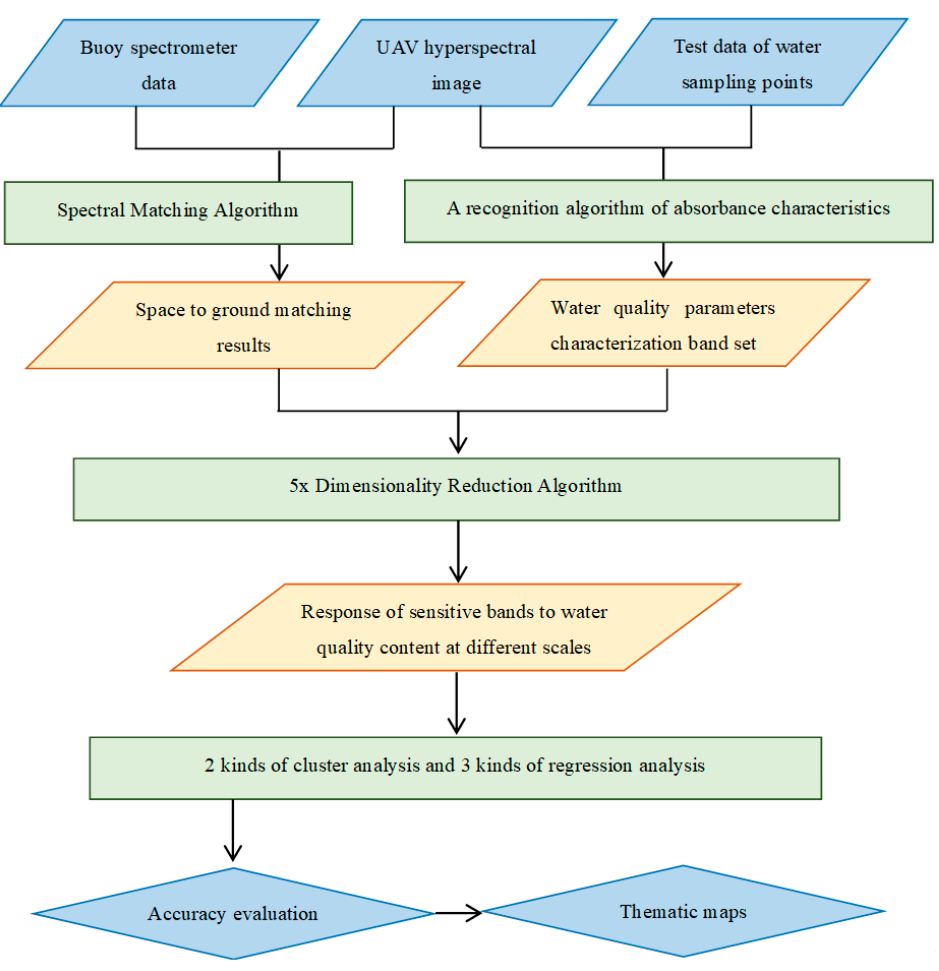
Figure 4. Workflow of the new method for calculating water quality parameters by integrating space–ground hyperspectral image data and spectral–in situ assay data.